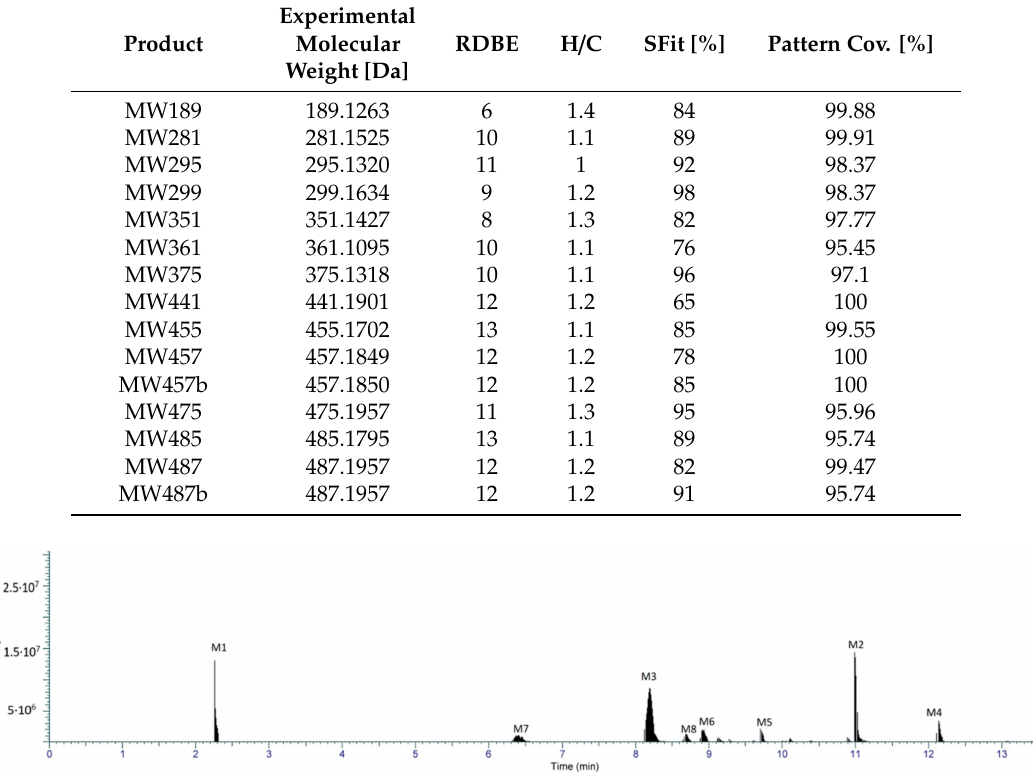
Table A1. Experimental molecular weights, ring and double bond (RDB) values, hydrogen vs. carbon atoms ratio (H / C) values, spectral similarity scores between theoretical and measured isotopic patterns (SFit), and matched intensity percentage of the theoretical pattern (Pattern Cov.), of the tentative metabolites of antazoline.